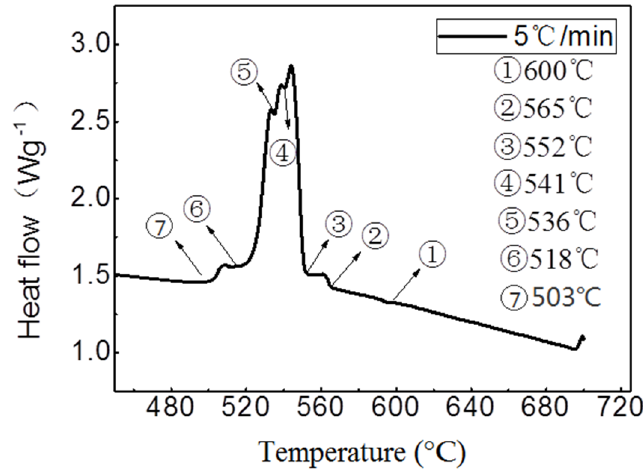
Figure 1. The DSC (differential scanning calorimetry) curve of the alloy with the cooling rate of 15 °C/s. Table 1. The preparation methods of different cooling rate alloys.